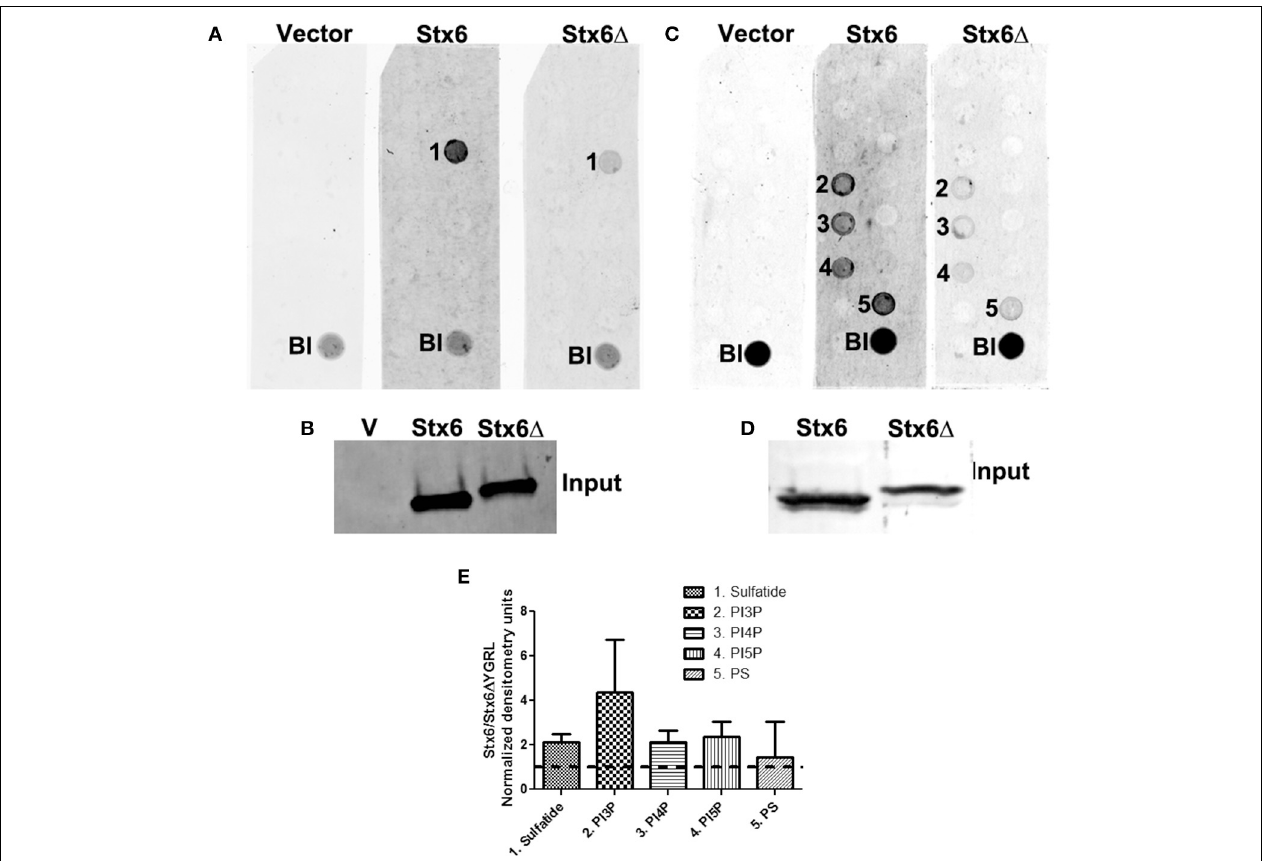
FIGURE 6 | Syntaxin 6 and syntaxin 6 (cid:2) YGRL protein-lipid interactions. 3XFLAG empty vector (V), 3XFLAG-syntaxin 6 (Stx6) and 3XFLAG-syntaxin 6 (cid:2) YGRL (Stx6 (cid:2) ) were immunopreciptated from HeLa cells and incubated with Sphingostrips (A) or PIPstrips (C) . Protein-lipid interactions with sulfatide (1), phosphatidylinositol 3-phosphate (PI3P) (2), phosphatidylinositol 4-phosphate (PI4P) (3), phosphatidylinositol 5-phosphate (PI5P) (4), and phosphatidylserine (PS) (5) were detected by blotting with anti-3XFLAG. The blank (Bl) is illuminated for orientation purposes. Protein input for